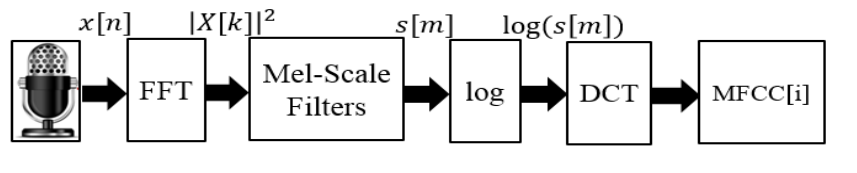
Figure 2. MFCC feature